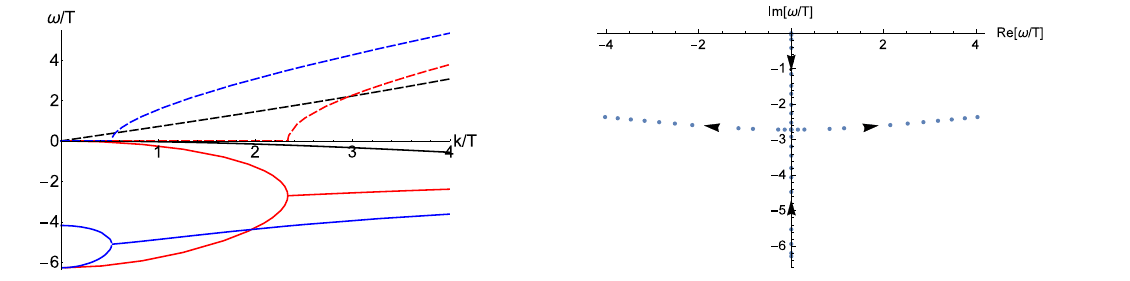
Figure 4 . The lowest modes in the Schwarzschild background. The (black) gravi- tational curve is solely in the gravitational sec- tor and thus both a CM and a QNM. The low- est electromagnetic CM (blue) and QNM (red) are distinct. Real parts are shown as dashed lines and positive to lessen clutter (a negative real part is also a solution). Imaginary parts are solid lines (and always negative).